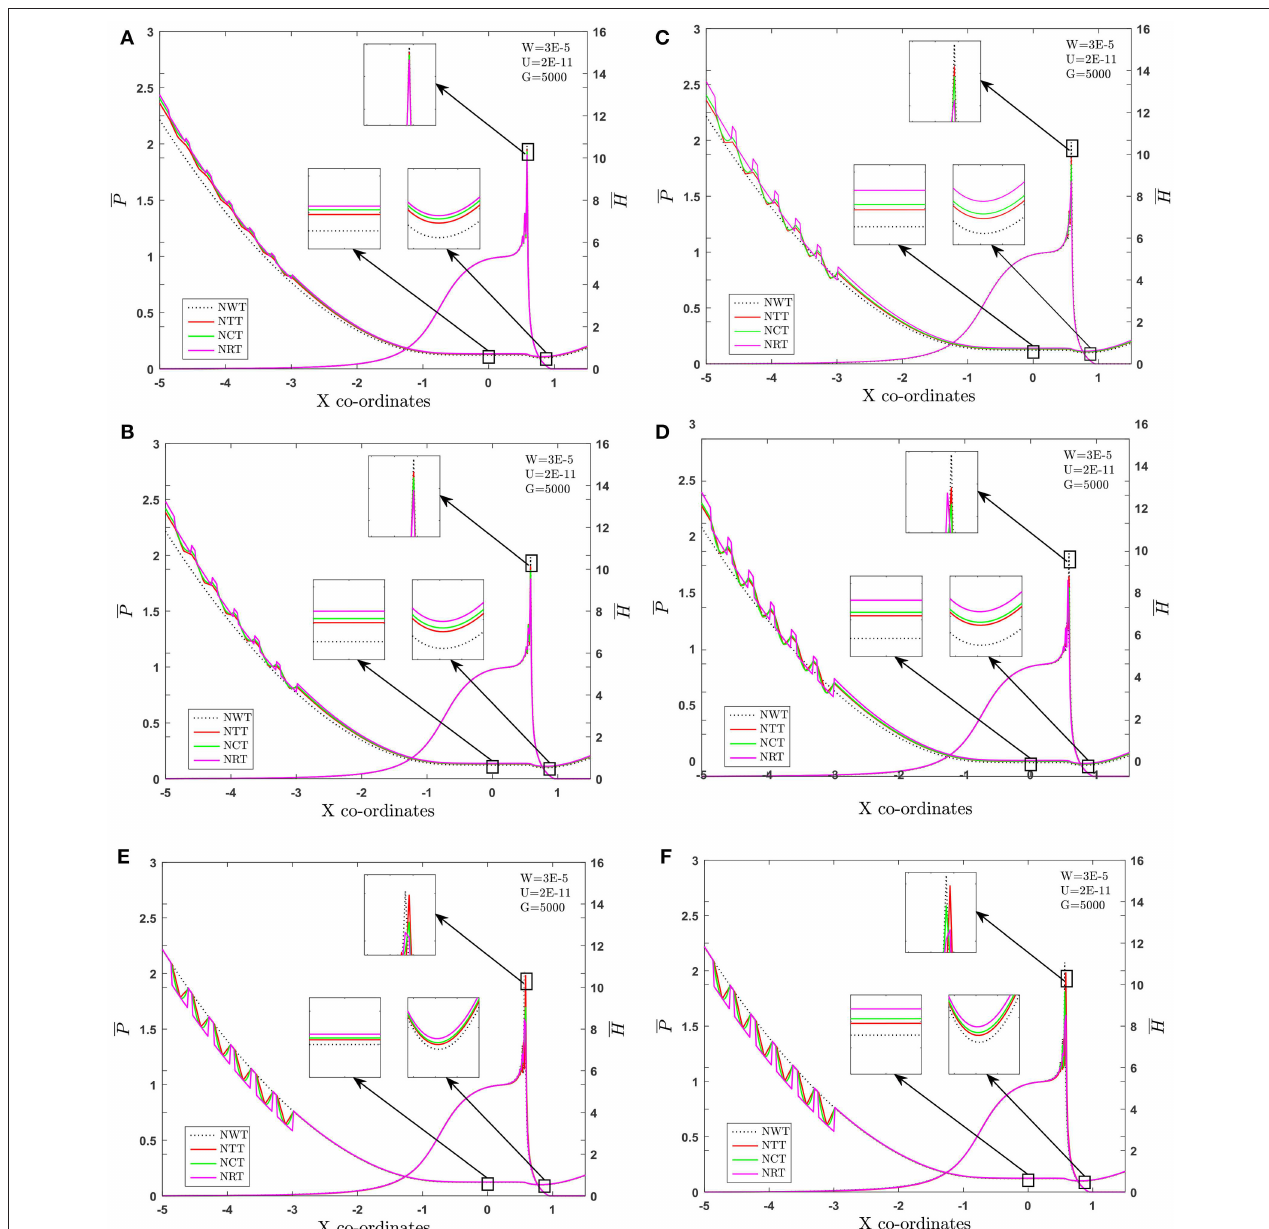
FIGURE 6 | Effect of different micro depth [ (A) 0.2, (B) 0.4, (C) 0.6, (D) 0.8, (E) 1.0, and (F) 1.2] of micro dimple on fluid film thickness. reduces. Load support mechanism in the presence of shallow micro dimples causes hydrodynamic pressure to build up in the converging zone of the micro dimples and also causes cavitation in the diverging section of the micro dimples (Yu and Sadeghi, 2001; Cupillard et al., 2008). Lastly, the micro-dimples with a depth beyond “1.0” causes reduction in the film thickness and pressure gradients. It has also been observed that a cross- sectional area of the rectangle dimple offers additional space for the fluid film thickness to build up and hence increase the LCC (Elco and Hughes, 1962).